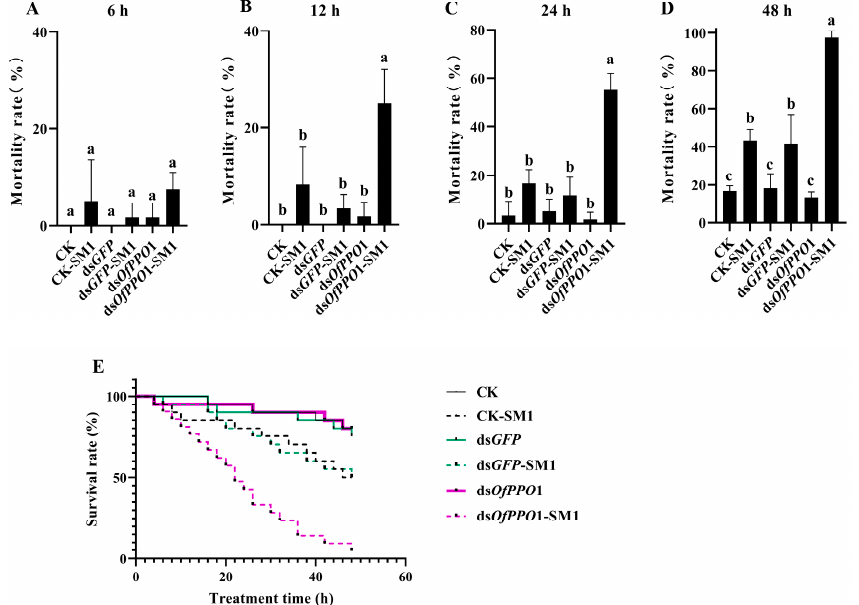
Figure 7. Bioassay test of SM1-challenged O. formosanus treated with ds OfPPO 1. ( A ) The mortality rate of O. formosanus in each group at 6 h. ( B ) The mortality rate of O. formosanus in each group at 12 h. ( C ) The mortality rate of O. formosanus in each group at 24 h. ( D ) The mortality rate of O. formosanus in each group at 48 h. ( E ) The survival rate of SM1-challenged O. formosanus treated with ds OfPPO 1. The data are presented as the mean ± SD of three replicates. In these figures, the same letters indicate no significant differences in the mortality of O. formosanus ( p > 0.05).